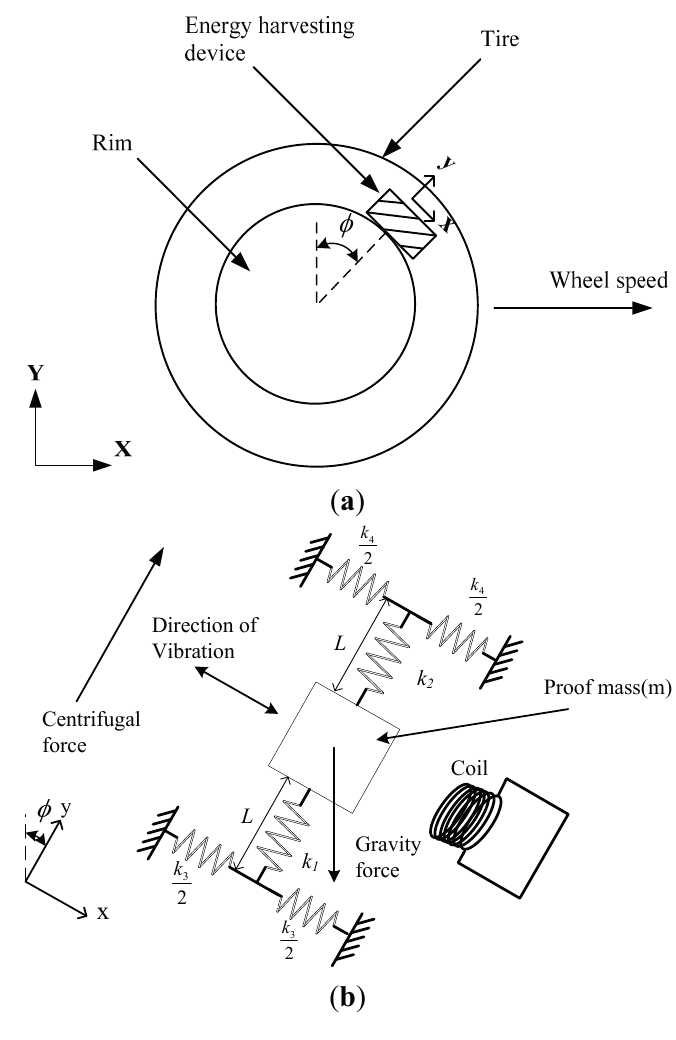
Figure 1. NSEH (nonlinear suspended energy harvester) embedded in a rotating wheel. ( a ) Schematic diagram of a rolling wheel. ( b ) Diagram of the